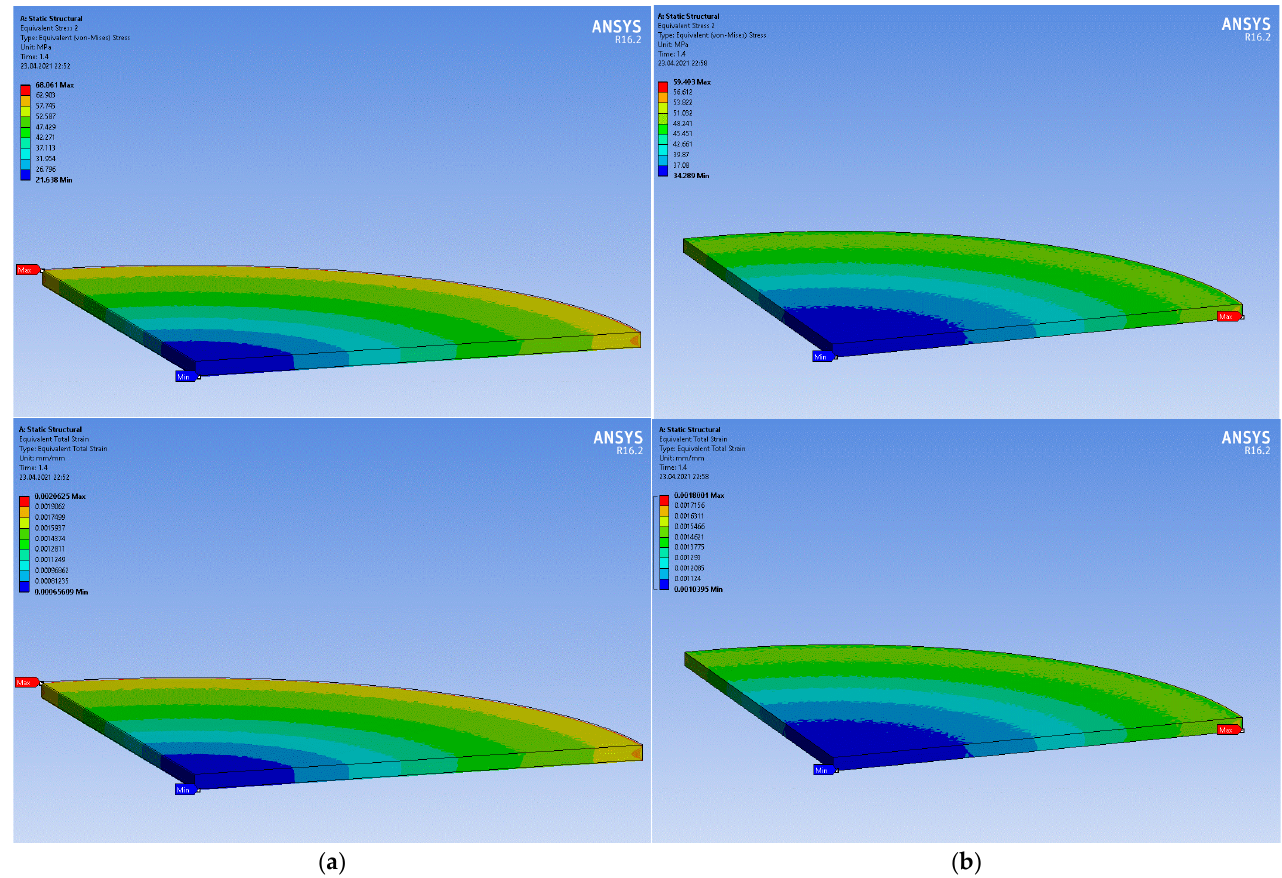
Figure 7. The equivalent stress distribution and total strain at the debonding area of the coating Al 2 O 3 with tensile force F = 14,000 N: ( a ) Modified specimen, type 2; ( b ) Elongated specimen, type 5. For geometric parameters, refer to Figure 2.